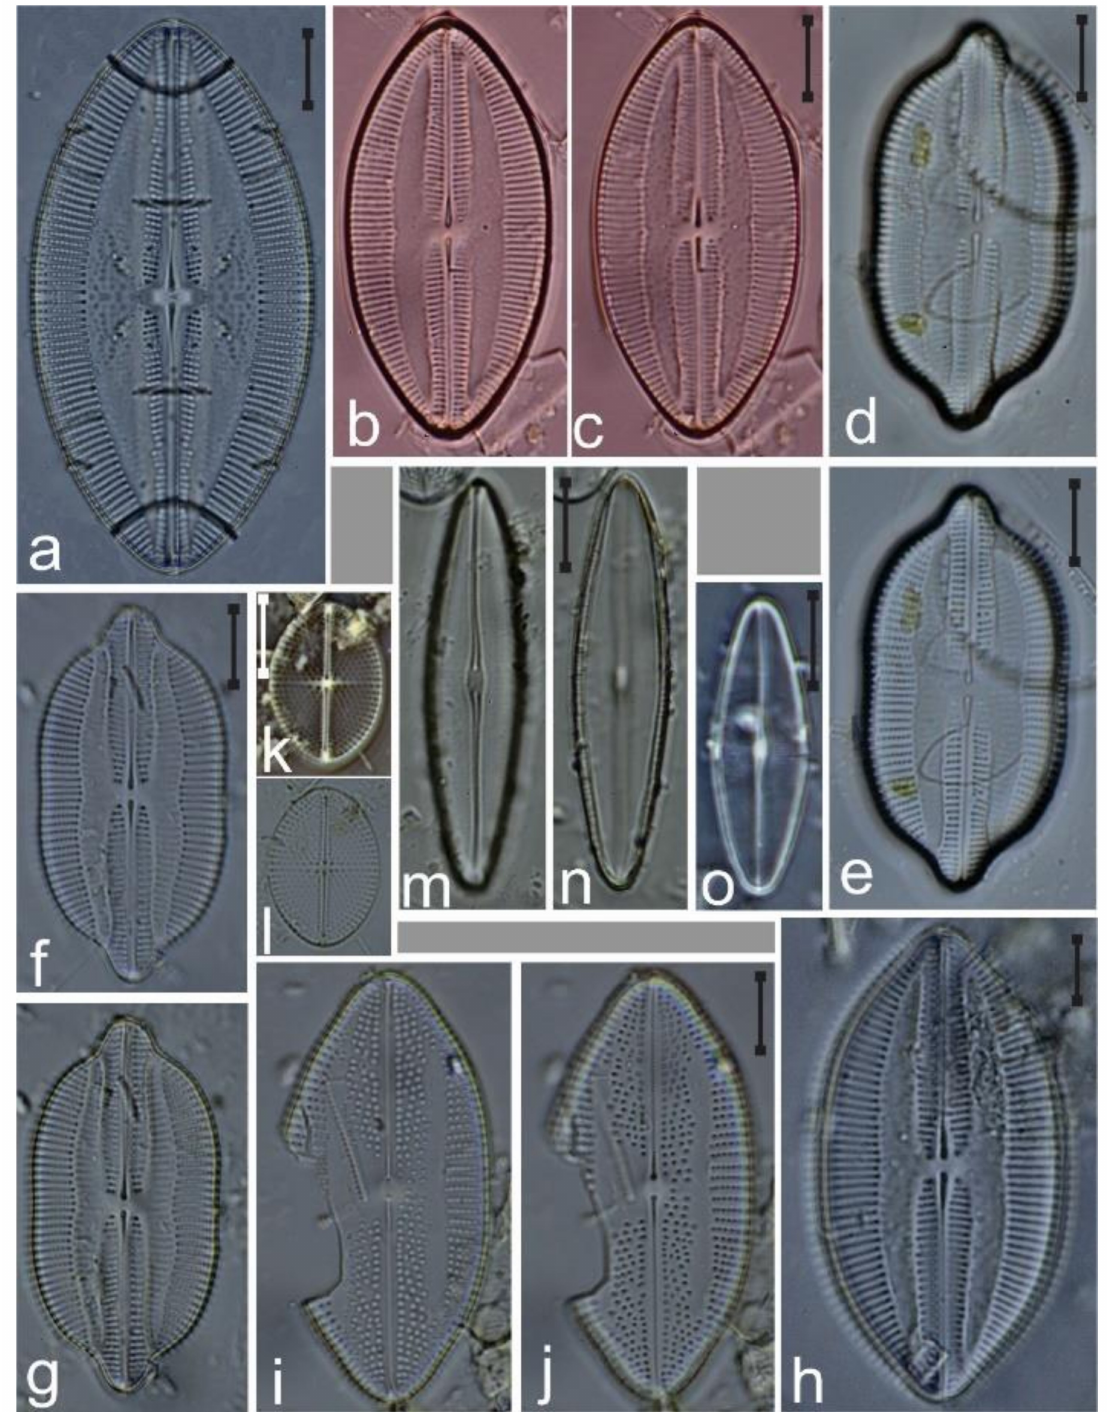
Figure 28. ( a – c ) Lyrella hennedyi ; ( d – g ) L. clavata var. caribaea ; ( h ) L. atlantica ; ( i , j ) L. approximatoides ; ( k , l ) Mastogloia binotata ; ( m , n ) M. ciskeiensis ; ( o ) M. chersonensis . Scale bar = 10 µ